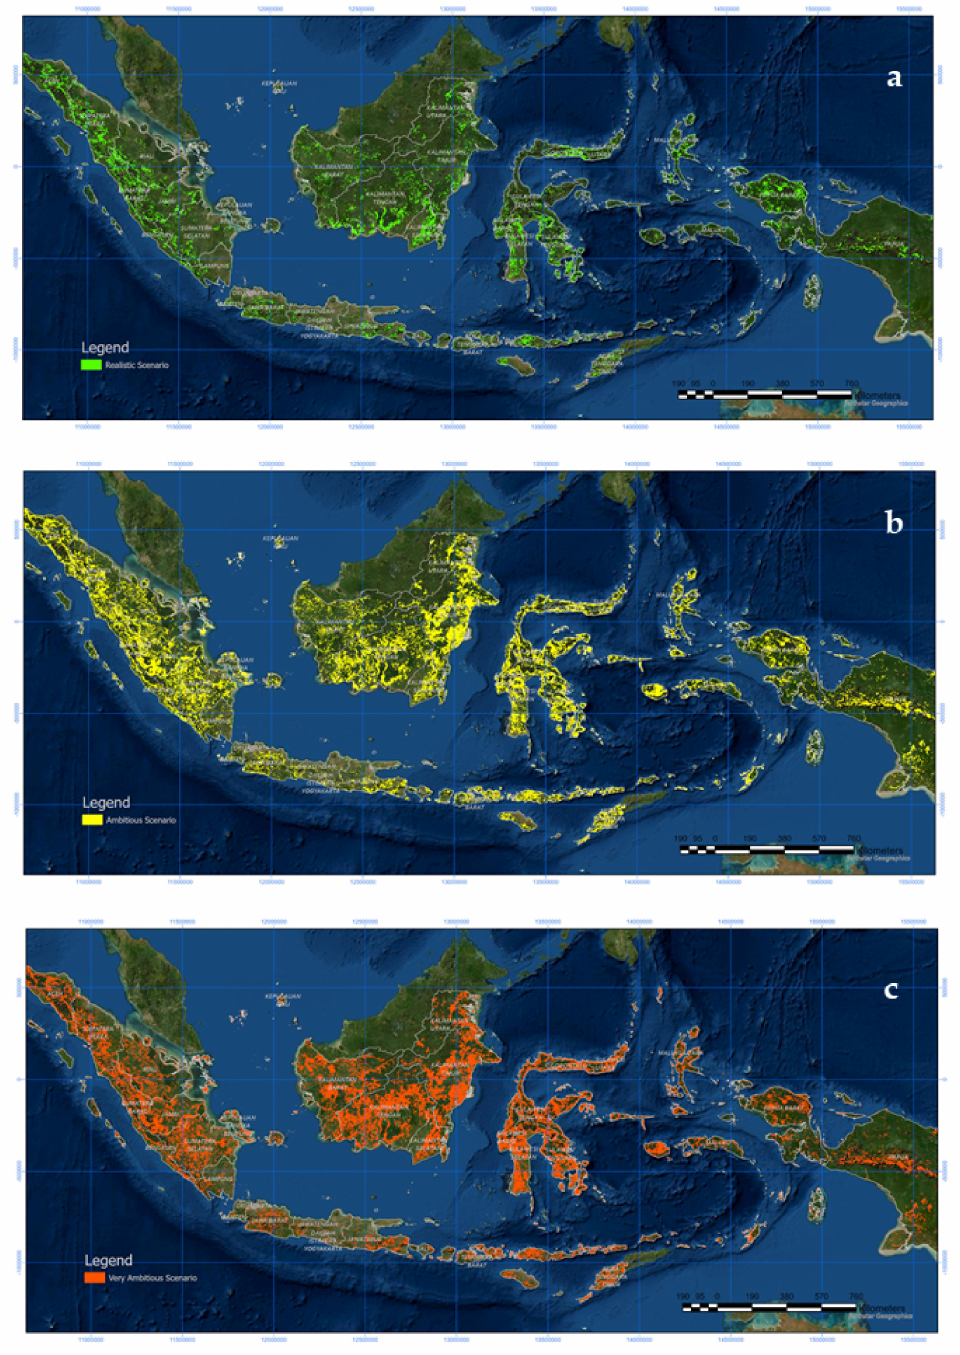
Figure 1. Map of reforestation opportunities in Indonesia based on ( a ). Realistic (bright green, above); ( b ). Ambitious (bright yellow, middle); and ( c ). Very Ambitious (bright orange, below)